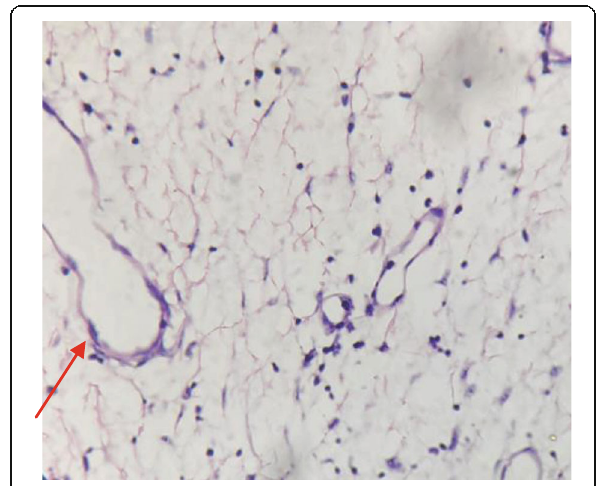
Fig. 9 H and E stained LP (magnification 100x) and HP (magnification 400x) photomicrographs showing dilated lymphatic channels (red arrow) alongwith lymphoid aggregates (black arrow) which are consistent with a diagnosis of Lymphangioma